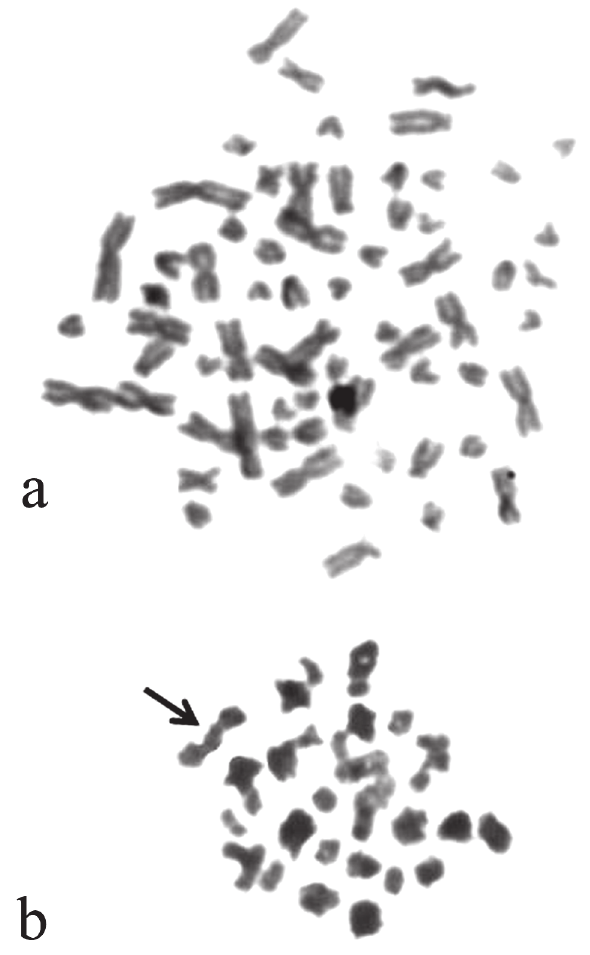
Fig. 1. Meiotic chromosomes of Potamotrygon falkneri sample from Ilha Solteira. Spermatogonial metaphase (2n = 65 chromosomes) after Giemsa staining ( a ) and metaphase I, with 31 bivalents and a trivalent (arrow) ( b